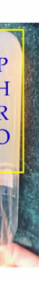
Figure 2. Picture of PHRO before and after crosslinking. ( a ) Before crosslinking; ( b ) after crosslinking (the formula is 0.4 wt% PAM + 0.5 wt% HMTA + 0.05 wt% RO + 0.3 wt% OA).